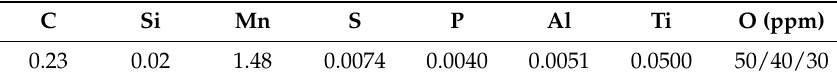
Table 2. Chemical composition of the selected steels (mass %).